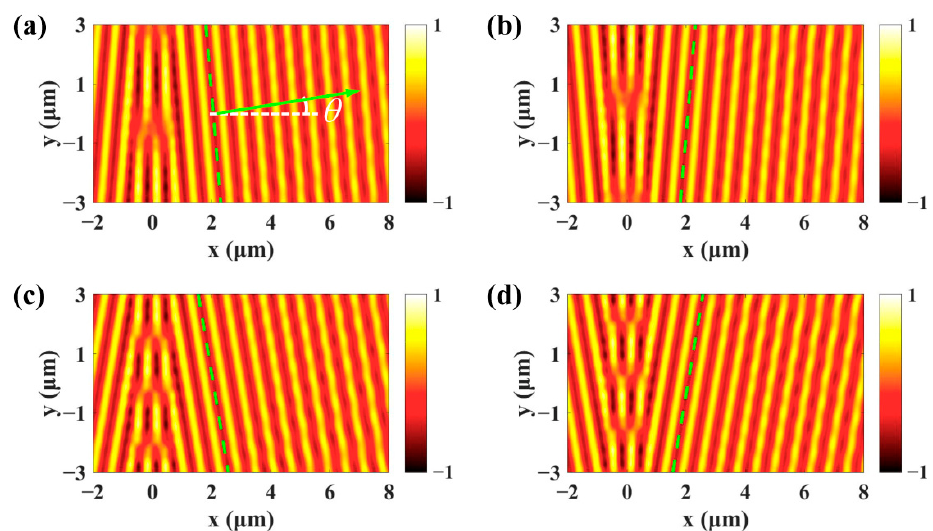
Figure 2. The propagation direction of the SPPs wave can be dynamically manipulated by changing the phase mask loaded on the SLM. ( a – d ) The real parts of SPPs field excited by the α = 5 ◦ , α = − 5 ◦ , α = 10 ◦ , and α = − 10 ◦ incident light,